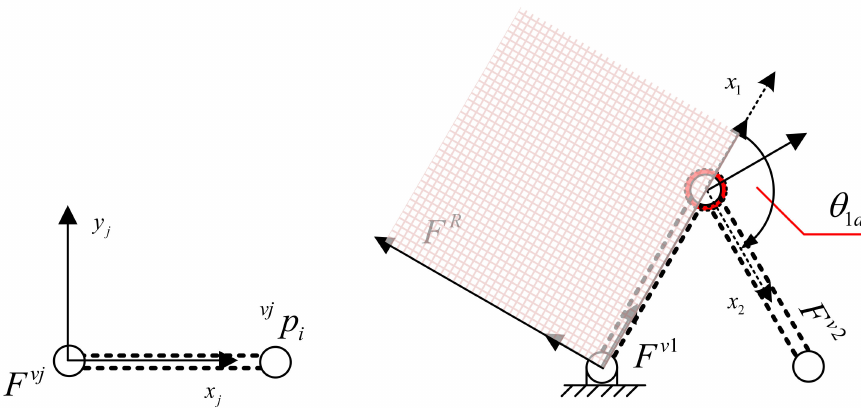
Figure 8. Definition of a virtual link’s coordinate frame and virtual joint angle.